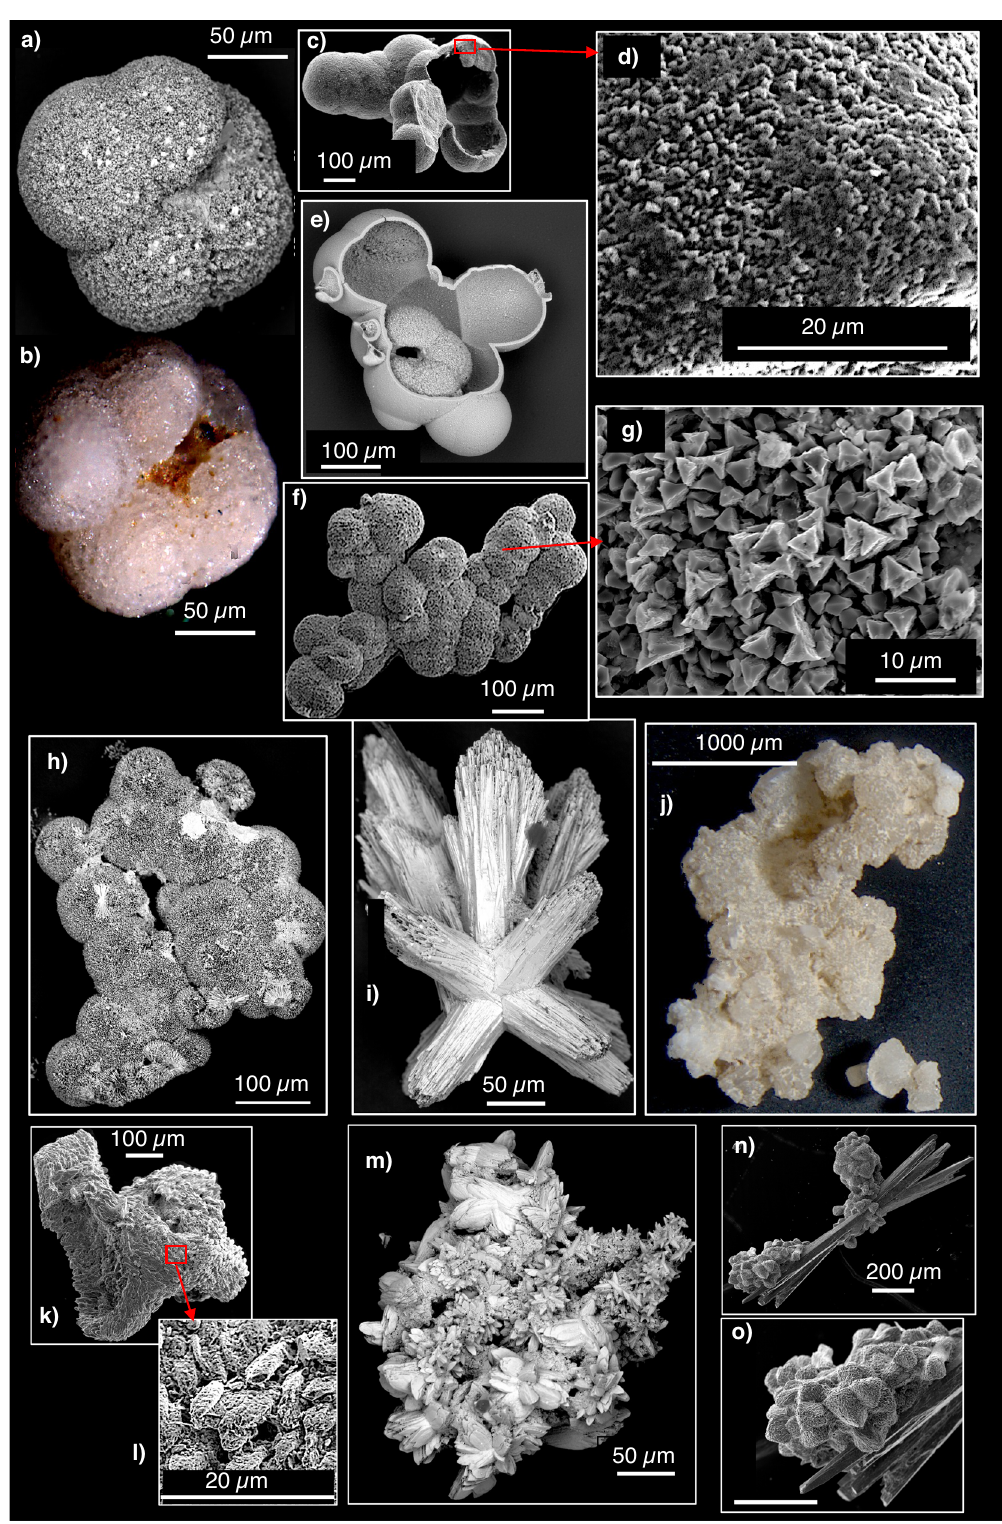
Fig. 3 Surface texture of heavily encrusted N. pachyderma tests and sedimentary authigenic crystals. a , b Brownish discolored overgrowth of